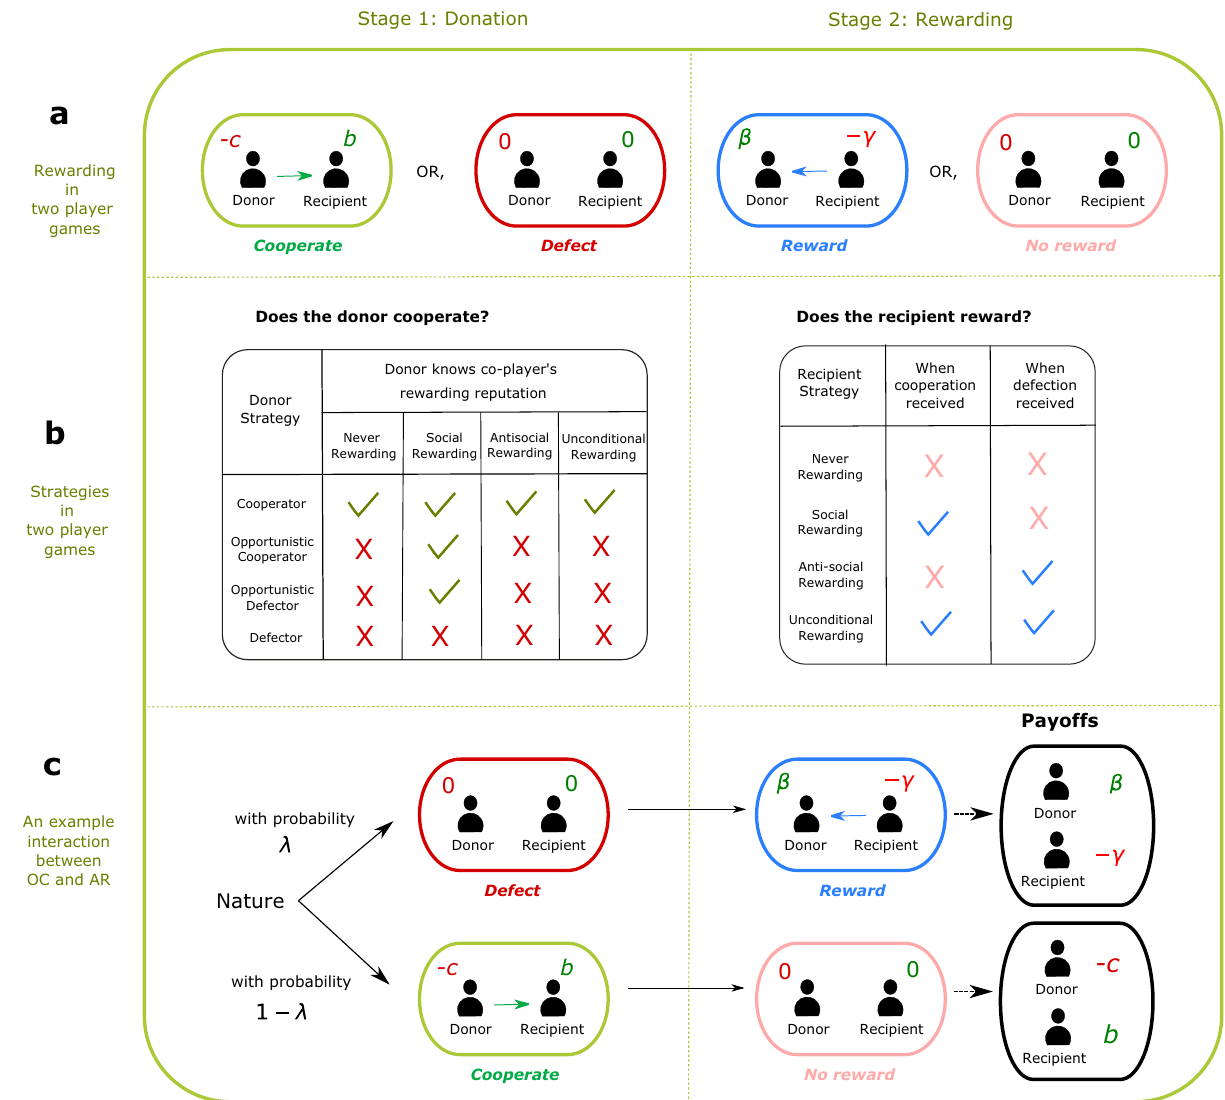
Fig. 1 | Setup and strategies of the two-player donation game with rewarding. a For the baseline model, we consider interactions between two individuals, a donor and a recipient. First, the donor decides whether or not to pay a cost c to provide a bene fi t b to the recipient. We refer to the two possible actions as cooperation and defection, respectively. Afterwards, the recipient decides whether or not to reward the donor. Rewards come at a cost γ to the recipient and yield a bene fi t β to the donor. b Recipients can choose among four pos- sible strategies (right panel). They either reward no one (NR for never rewarding), reward cooperators only (SR for social rewarding), reward defectors only (AR for antisocial rewarding), or reward everyone (UR for unconditional rewarding). To describe the donor's possible strategies (left panel), we assume that donors know a recipient's rewarding strategy